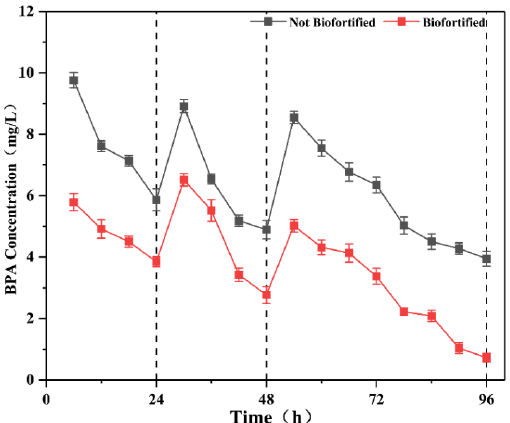
Figure 8. Bisphenol A (BPA) residues in biofortified sequencing batch reactors (SBR).